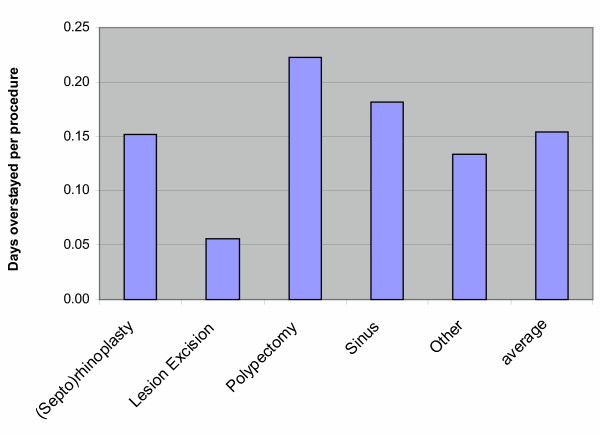
Days overstayed as a fraction of the procedures performed.